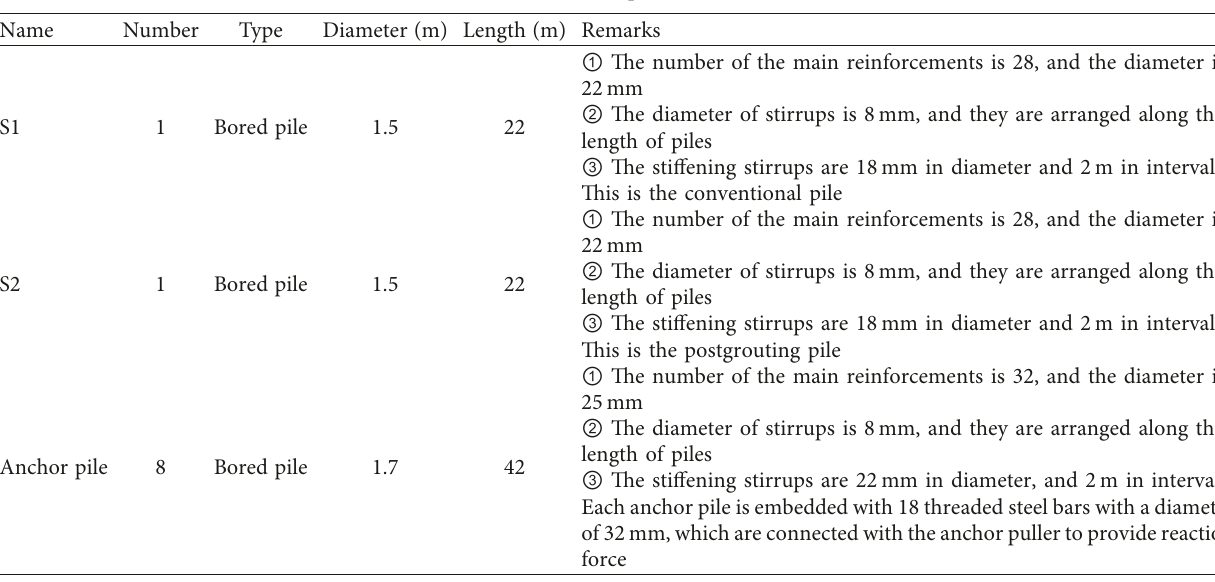
Table 2: Pile parameters.